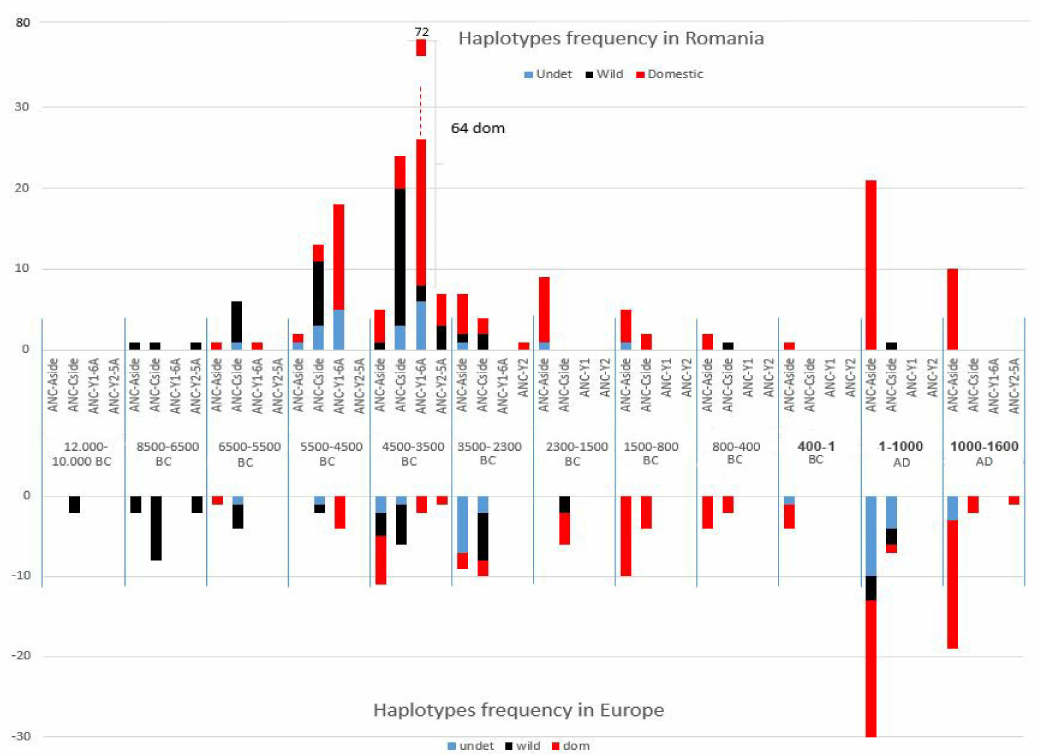
Figure 5. Timing of haplotypes frequency for Sus scrofa on Romanian territory versus